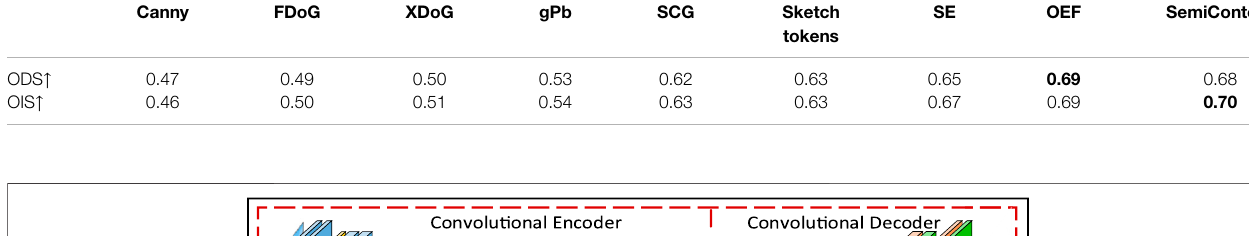
TABLE 2 | Performance comparison of conventional edge detection based algorithms on the NYUD dataset. Canny FDoG